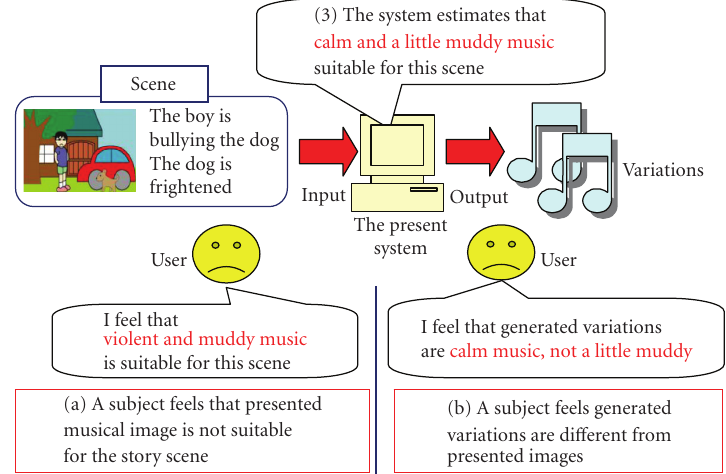
Figure 7: MNN models adjustment.